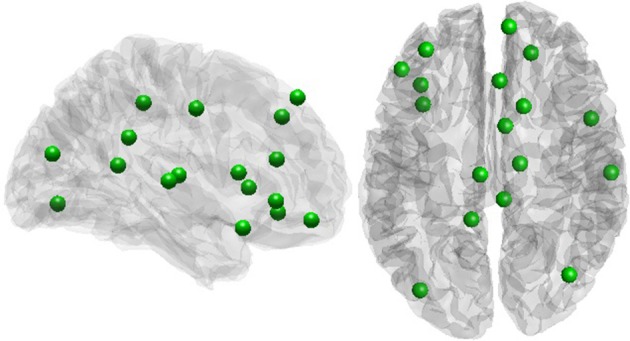
Rich club members.